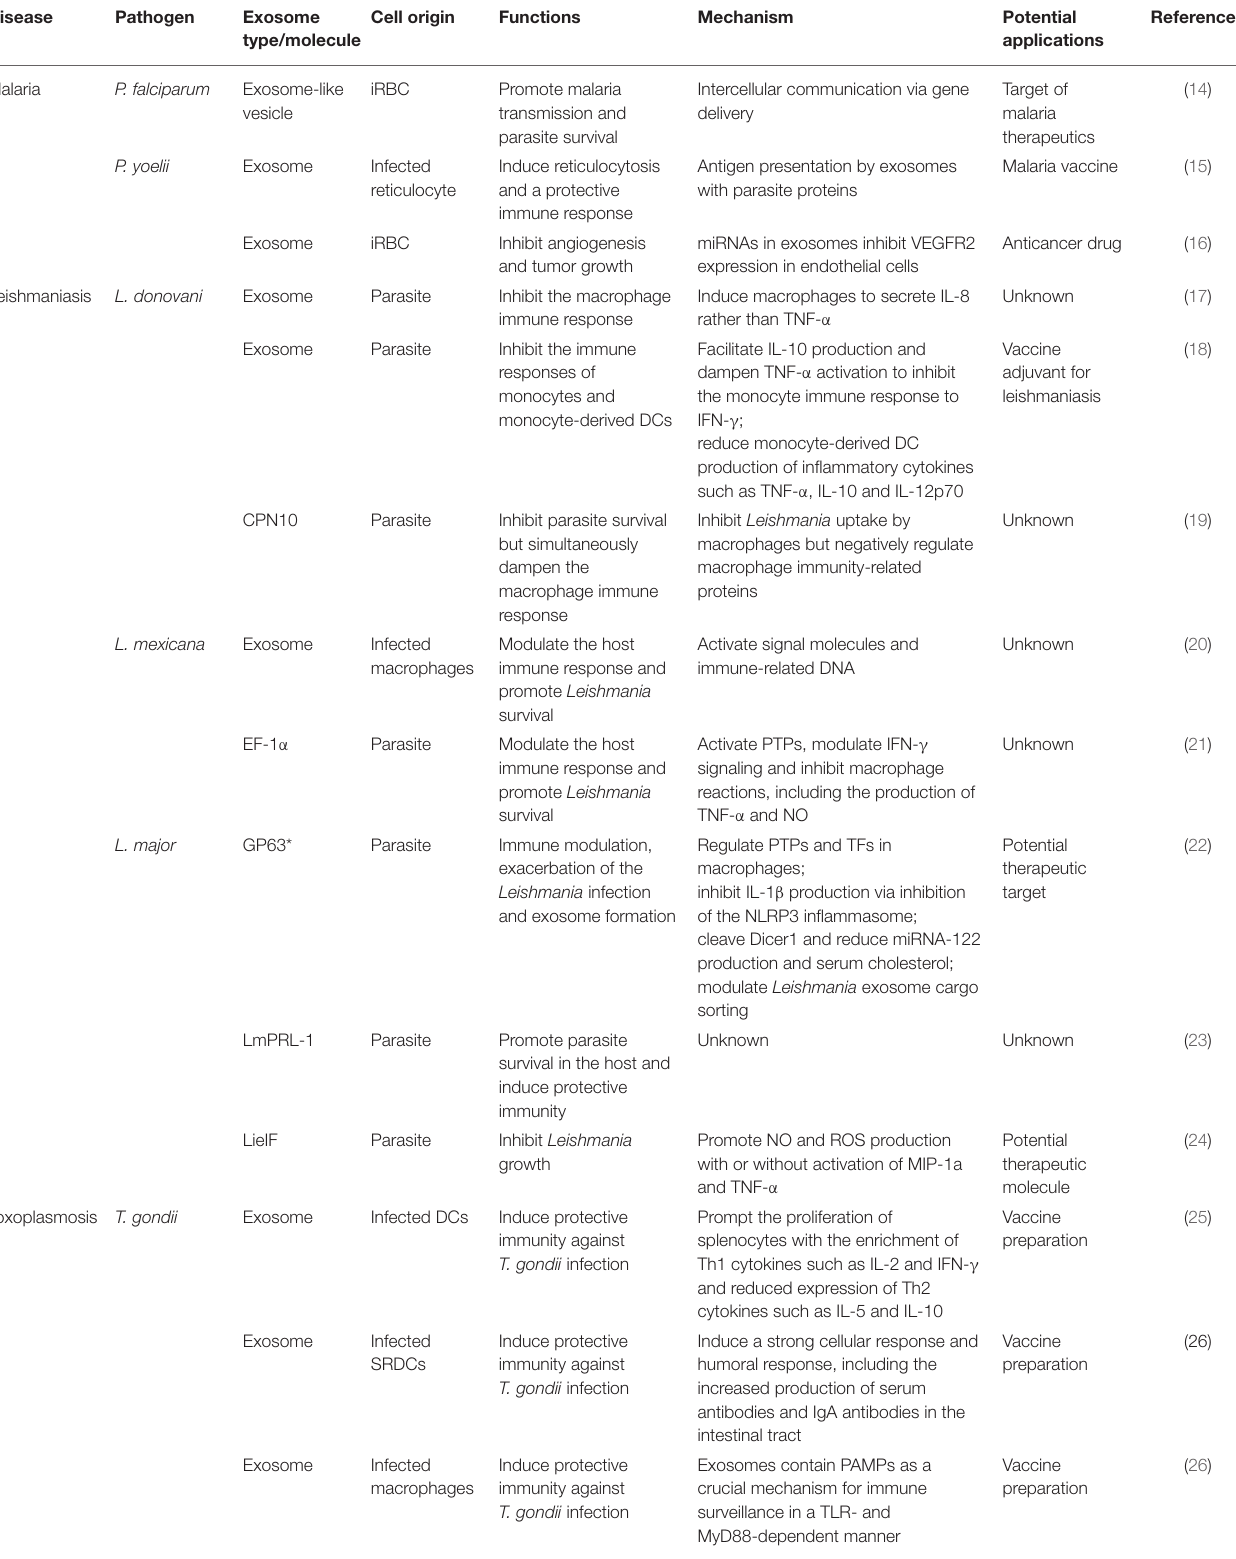
TABLE 2 | Essential information on various exosomes and exosomal molecules in different parasitic